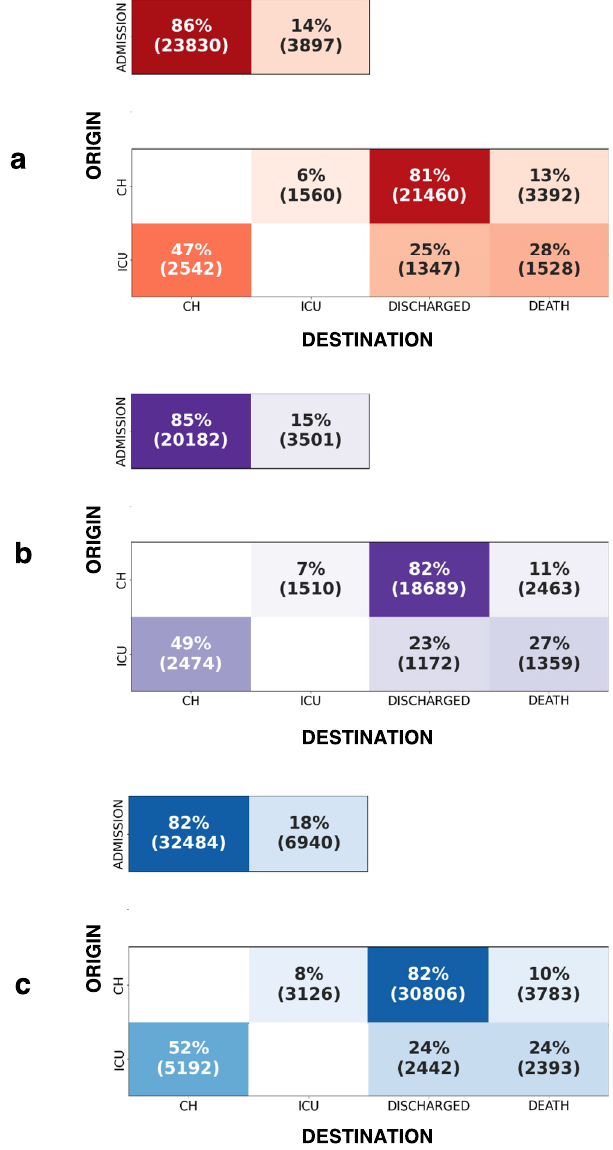
Figure 2. Global transition matrices for each period (or wave). Insets A, B, and C stand for first, second, and third period, respectively. This figure shows the probability of destination given the origin: p(destination|origin). The transition matrices can be read as follows: each box corresponds to the number of stays originating from a particular hospital ward (rows: admission, CH, ICU; total of each row is 100%) and for which transition is made the following day to another hospital ward or state. For example, if we consider all the transitions from CH, 81% of them were directed to